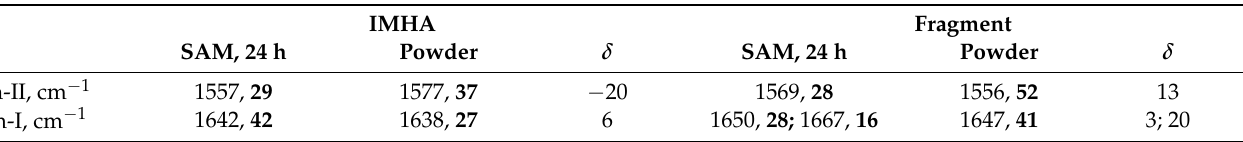
Table 2. Wavenumbers and FWHM (bold) of Am-I and Am-II modes of IMHA and fragment mol- ecule obtained from samples in powder form and SAMs.